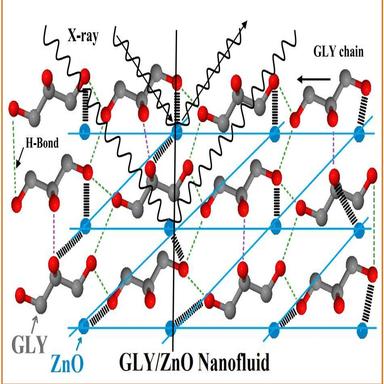
The sketch of hydrogen–bonded 3D supramolecular structure of glycerol molecules along with orderly arranged ZnO nanoparticles. The electrostatic interaction between the glycerol molecules and ZnO nanoparticles provided high suspension stability to the nanoparticles in the highly viscous media. This structure satisfied the Bragg's law conditions and produced the characteristic diffraction peaks of ZnO for the GLY/x (wt%) ZnO nanofluid samples for x 0.30. In the sketched GLY/ZnO nanofluid structure, the sizes